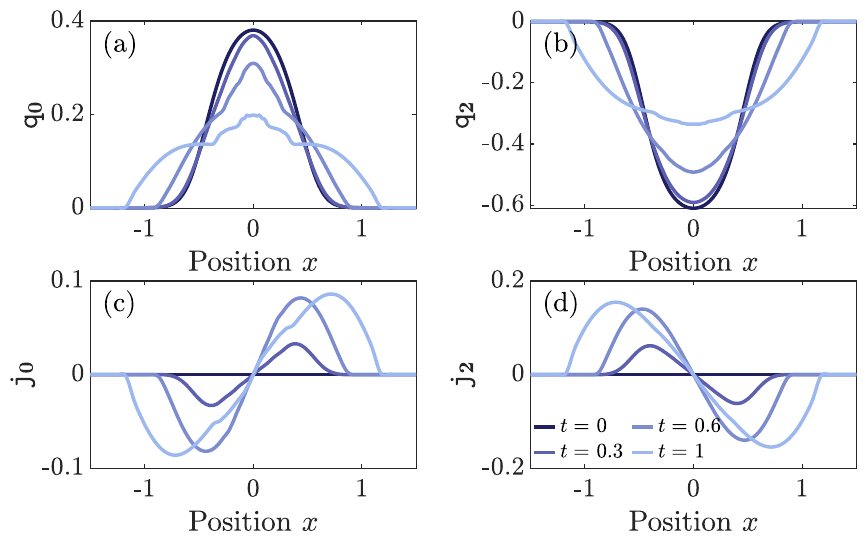
Figure 4: Expectation values of charge densities and their associated currents as function of x for the XXZ model. The system is initialized in a parabolic, confining magnetic field, whereafter the field is gradually lowered. (a,c) Linear density and its current at different times. As the field is lowered the difference in velocity between the different quasiparticles becomes apparent. (b,d) Kinetic energy density and cur- rent at different times. The higher kinetic energy of first order quasiparticles hides the contribution from higher